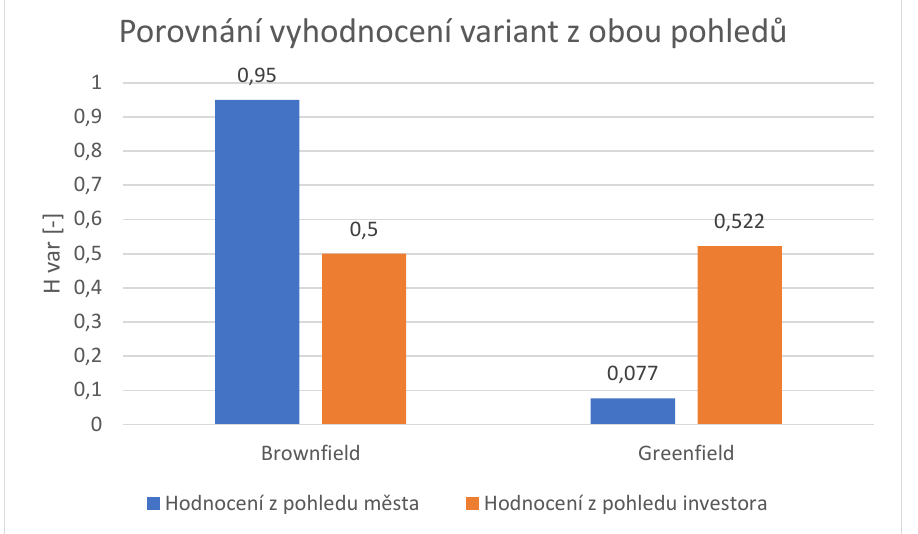
Vyhodnocení obou dvou pohledů, viz. Graf 1, vychází tak, jak je obecně známo. Z pohledu města je jednoznačně výhodné snižování počtu brownfield, zatímco pro investora je spíše výhodnější výstavba na zelené louce.